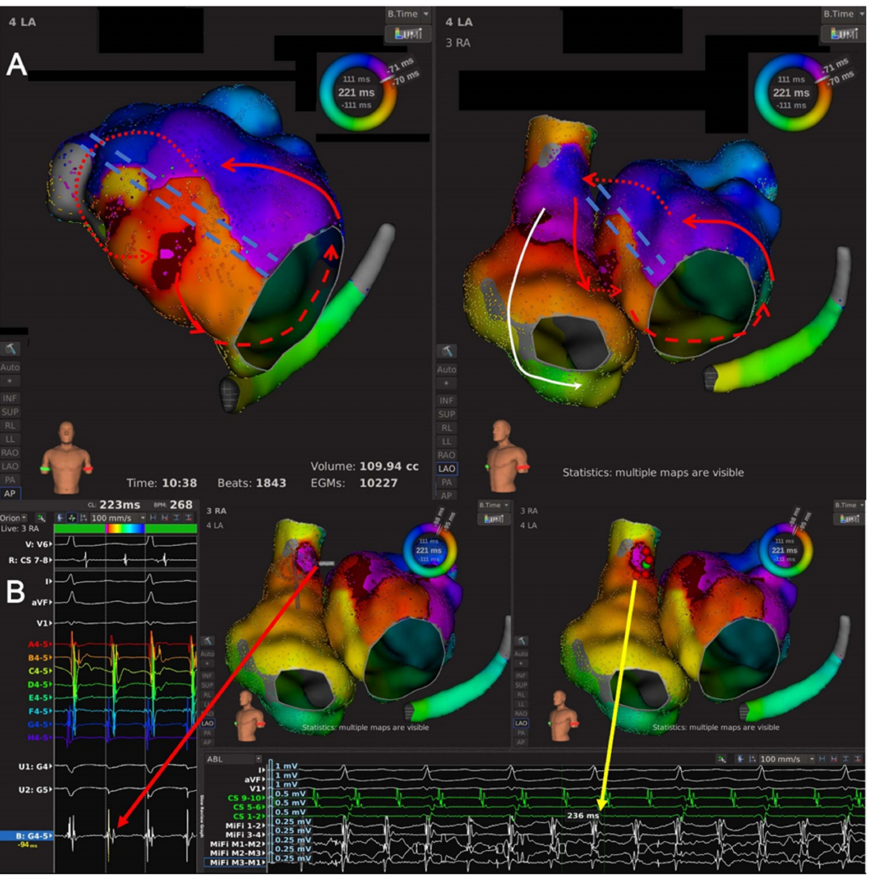
Figure 5. The high-density mapping of a Type 2.1 AT. ( A ) Activation map of a Type 2.1 AT from the anteroposterior view of LA (left) and the left-anterior oblique view of LA and RA (right). The high-density mapping identified one LAAW block line from the RSPV to the MVA, and the wavefront activated RA at the superior septum consistent with RA insertion of BB, ran down the septum and jumped to LA via the coronary sinus ostium. Then the wavefront ran around the MVA counterclock- wise to LAAW and returned to RA via the insertion of BB near LA roof. The red lines with arrows indicated the circuit of AT; the dashed red line indicated the circuit of AT behind the atrial structure; the dotted red lines indicated the inter-atrial bypasses; the arrowed white line indicated passive activation; the double-dashed blue line indicated the LAAW block of line. ( B ) Local map potentials of the LAAW gap during AT (left) and at the moment of AT cycle length change (bottom). The red dots indicated the ablation points; the green dot indicated the ablation site of cycle length change; the arrowed red and yellow lines indicated the local potentials during AT and at the moment of AT cycle length change (from 221 ms to 236 ms),